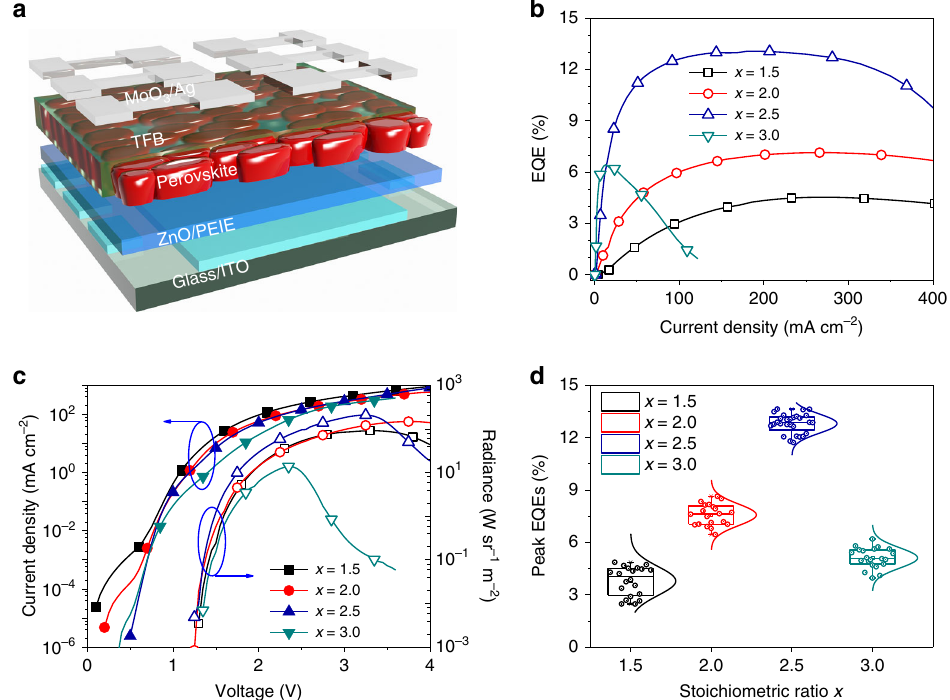
Fig. 1 Perovskite LEDs processed from precursors with excess FAI. a Schematic diagram of the device architecture of the perovskite LEDs in this work (ITO/ZnO/PEIE/perovskite/TFB/MoO 3 /Ag). b – d EQE -J ( b ), J & R-V curves ( c ), and statistical distributions of peak EQEs ( d ) of perovskite LEDs fabricated from precursors with different x values ( x = 1.5, 2.0, 2.5 and 3.0). For all box plots, the line in the center is the median value. The interquartile range (IQR) represents 25th-75th percentile of the EQE values. Whiskers show the extent of the whole EQE values, extending to 1.5 IQR in box-plots